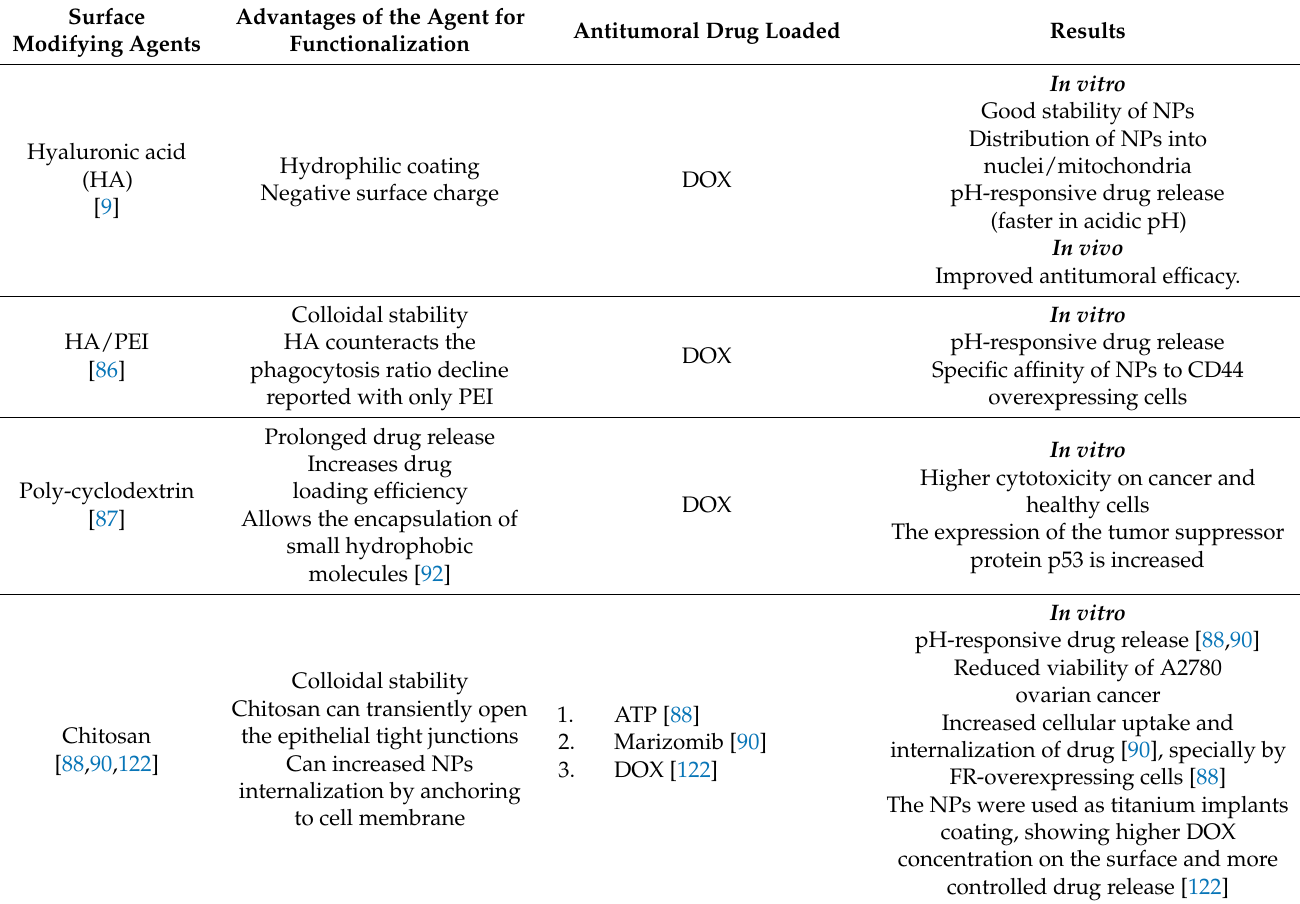
Table 1. Functionalization of HAp NPs for cancer